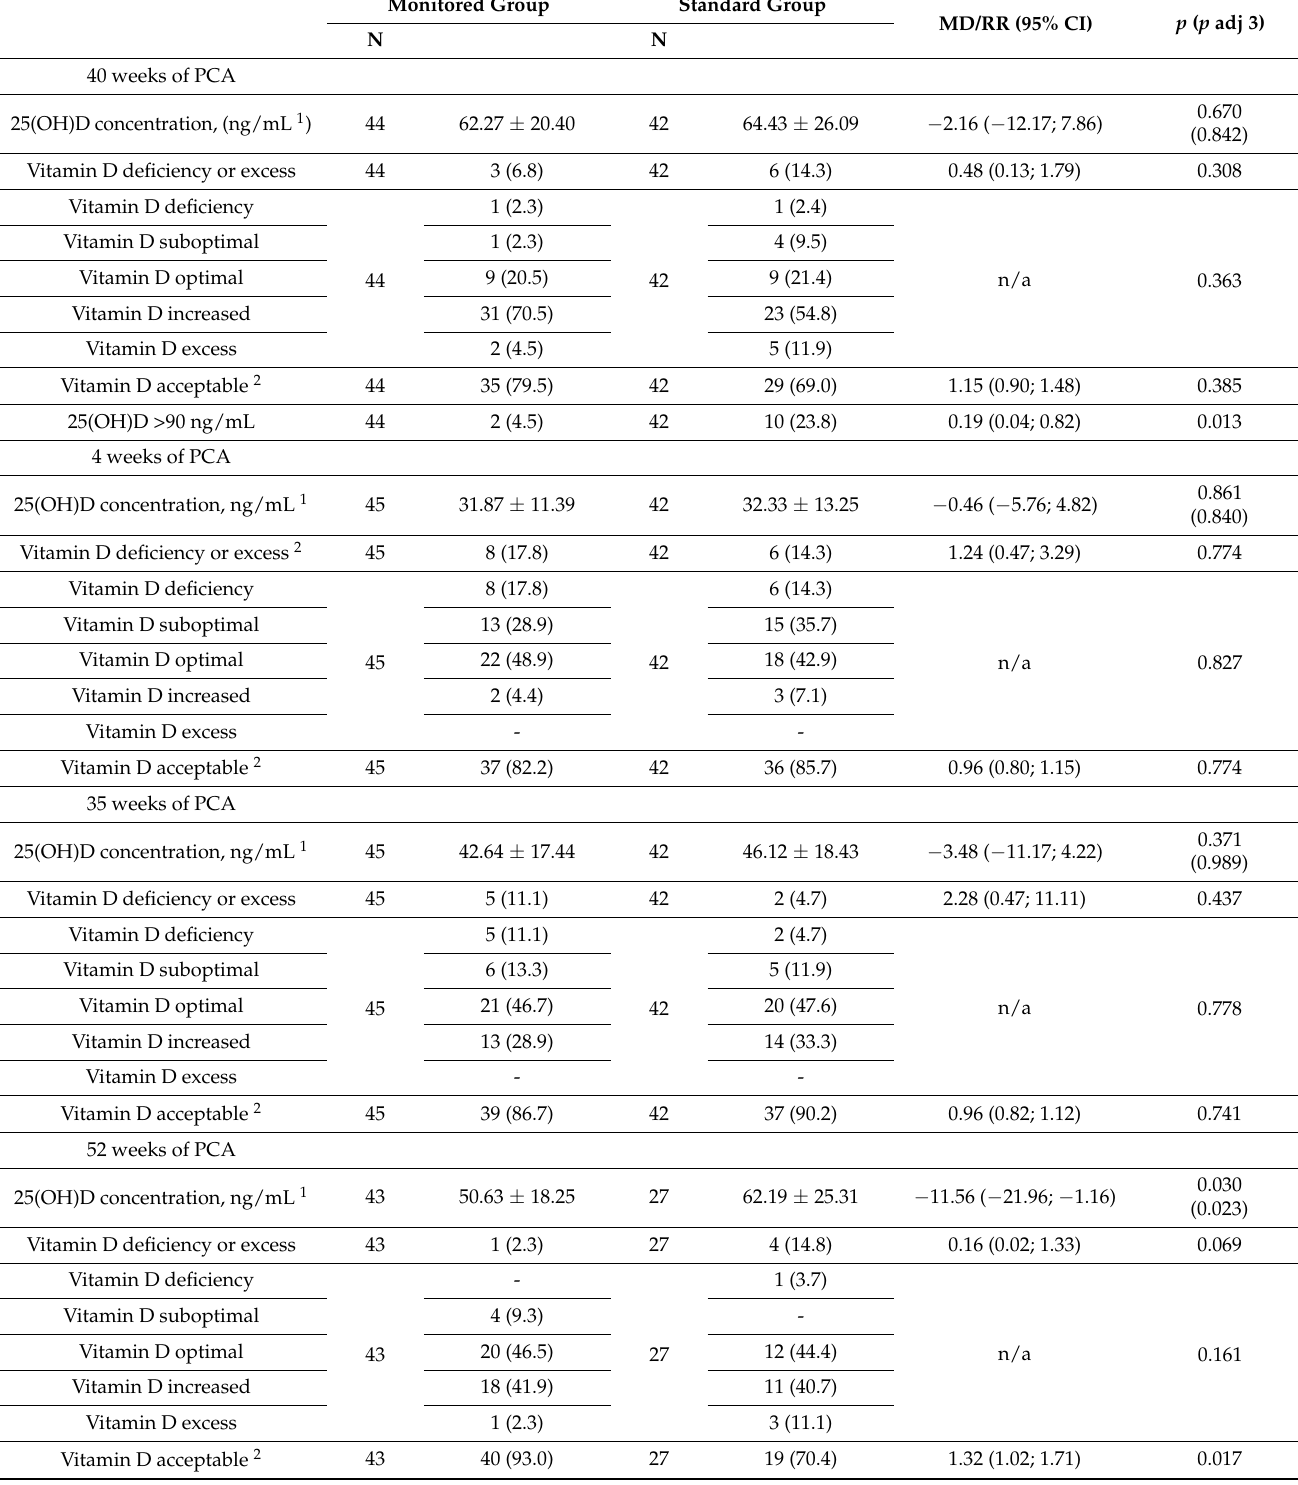
Table 3. Primary outcomes 25(OH)D levels between